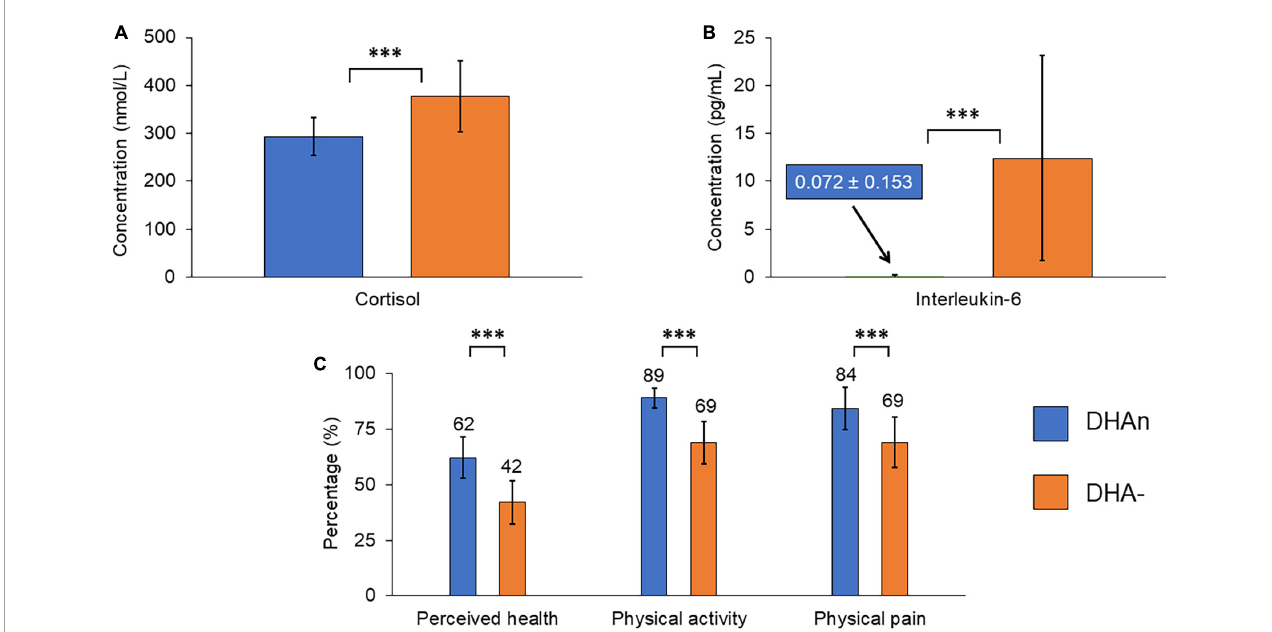
FIGURE2 Summary graph of the main differences observed between the two groups of patients: (A) Cortisol level, (B) interleukin-6 level, and (C) quality of life as measured by the SF-36 scale. The cortisol and interleukin-6 levels are increased in the DHA– group. Quality of life dimensions represented here are decreased in the DHA– group. Error bars are standard deviations. ∗∗∗ Means p < 0.05 by χ 2 test for nominal variables and T -test for continuous